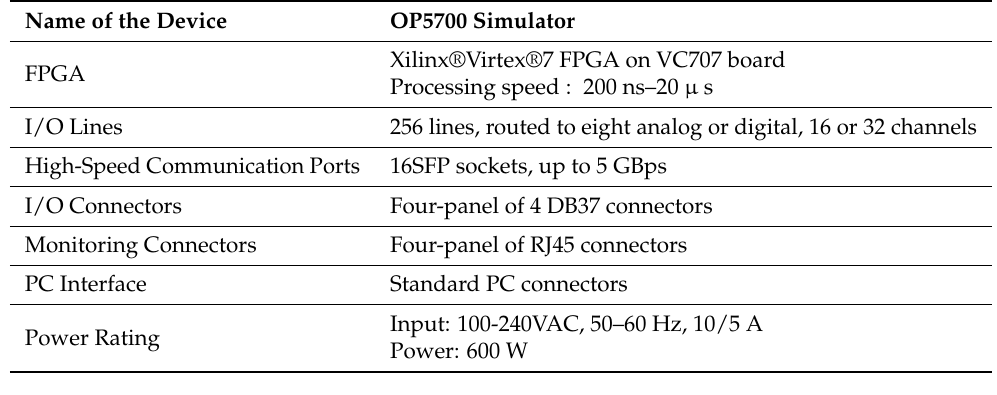
Table 3. Specifications of the OP-5700 HIL simulator.